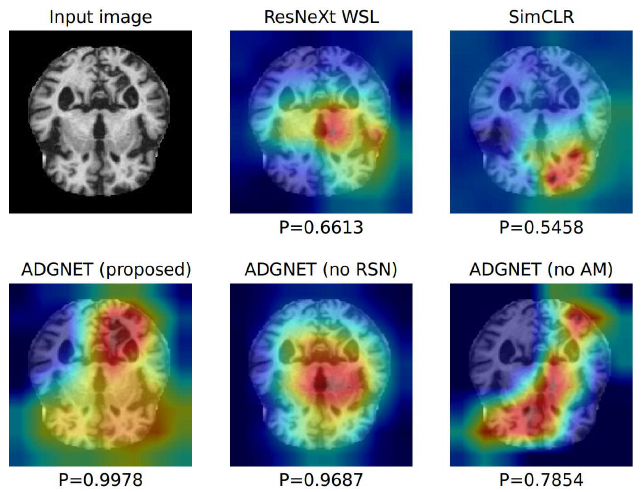
Figure 7. Visualization of heatmaps. We compare the visualization heatmaps of the ADGNET (proposed, no reconstruction sub-network (RSN) and no attention module (AM)), the ResNeXt WSL (weakly supervised learning), and the SimCLR. The heatmap visualization is calculated for the last convolutional outputs and P denotes the prediction score of each network for the ground-truth